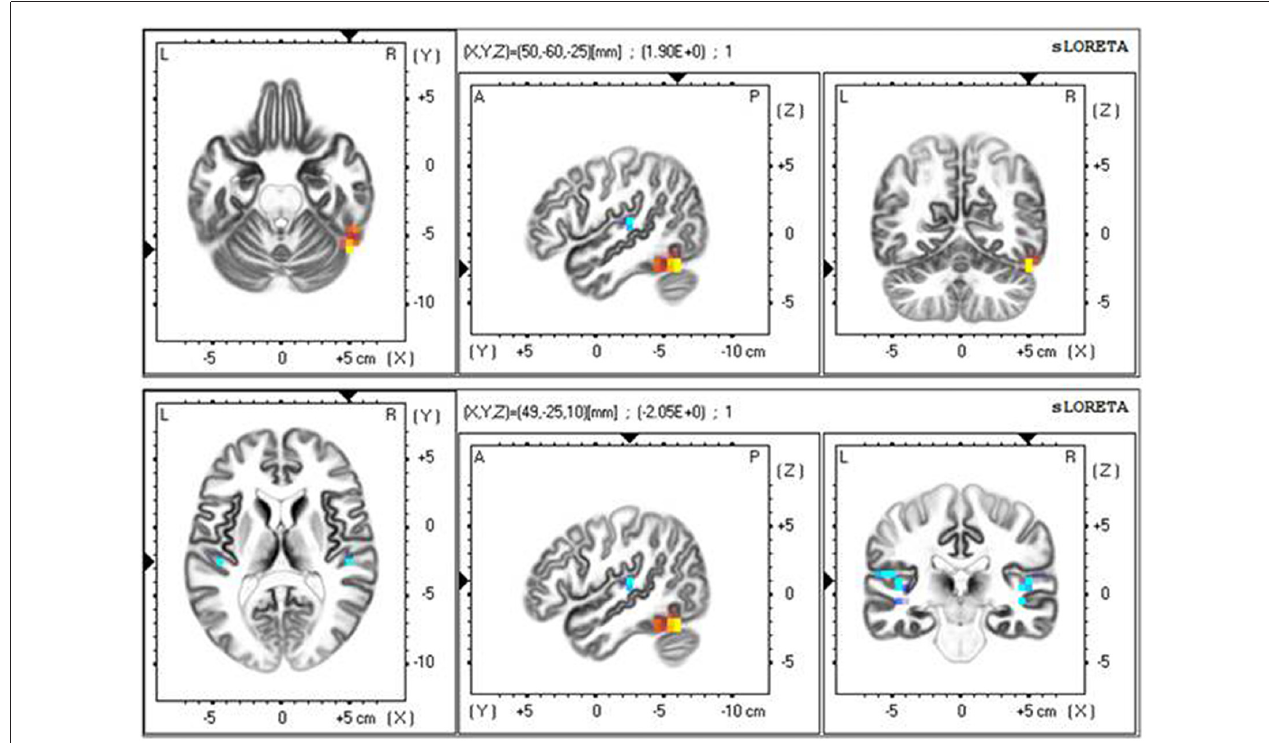
result showed that the response times when TMS was applied to the FEF at different time points were all longer than when